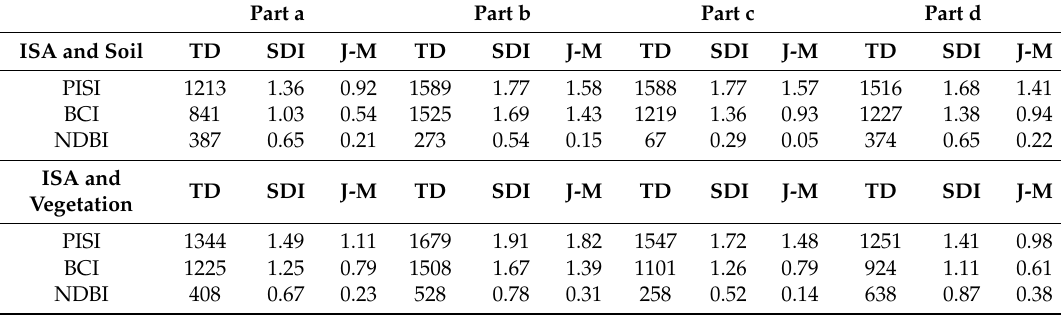
Table 2. Separability measures between ISA and soil and ISA and vegetation with different